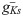
Both E/I balance and SFA level affect the spatio-temporal properties of cortical activities.(A.) Within the single bump the levels of gKs¯ and w
i → e determine the speed of propagation. However, SFA does have a much larger effect on wave speed than E/I balance. Panels B, C, and D show example raster plots for w
i → e = 10, 20, and 30 μS/cm2 respectively with gKs¯ = 0 mS/cm2on top and gKs¯ = 1 mS/cm2 on bottom. In each, black markers represent spikes from excitatory cells and red markers represent those from inhibitory cells. Cells are sorted by spatial coordinate, a measure described in the methods section.